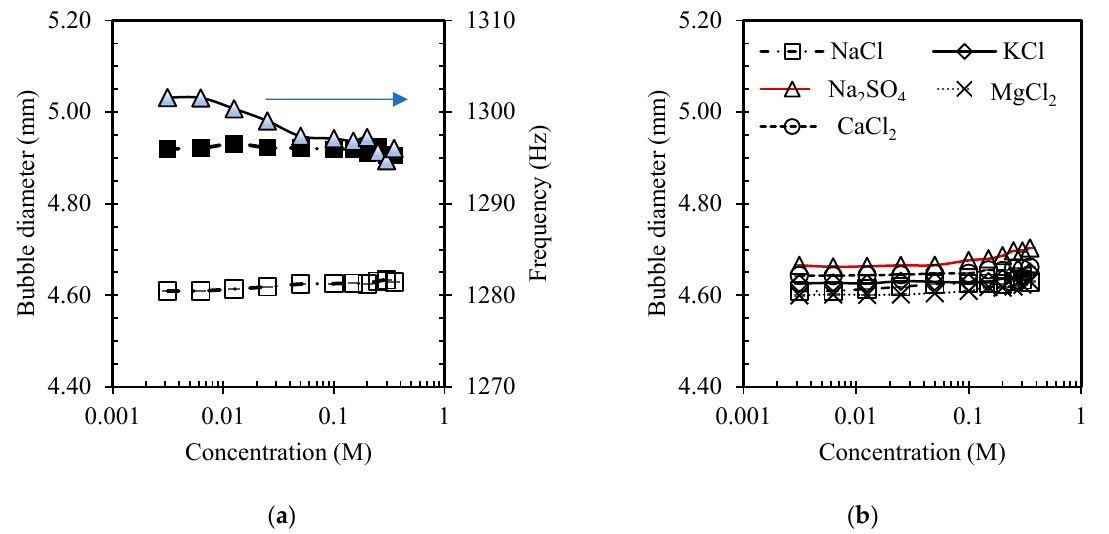
Figure 5. Bubble size in salt solutions: ( a ) Acoustic frequency vs. bubble size. The solid triangles with a gradient represent the acoustic frequency; the black squares are the bubble size estimated from image analysis; the open squares are the bubble size estimated from the Minnaert relationship. ( b ) Acoustically determined bubble size in different salt